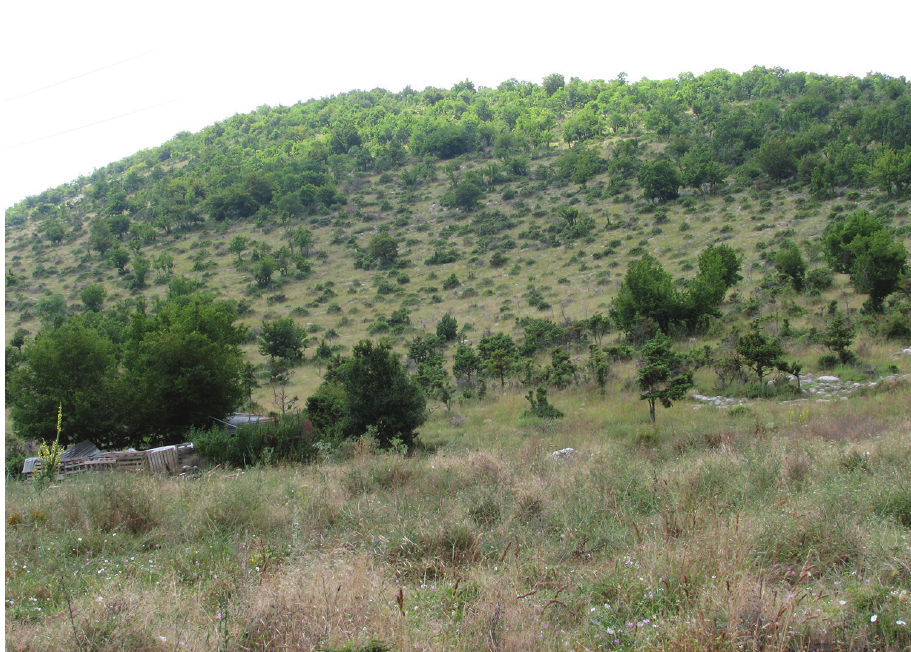
Figure 39. Habitat of P. orphicus eleniae in its type locality. Northern Greece, Makedonía, Dráma district, near Granítis, 900 m, 23 July 2008. Photo by V.A.